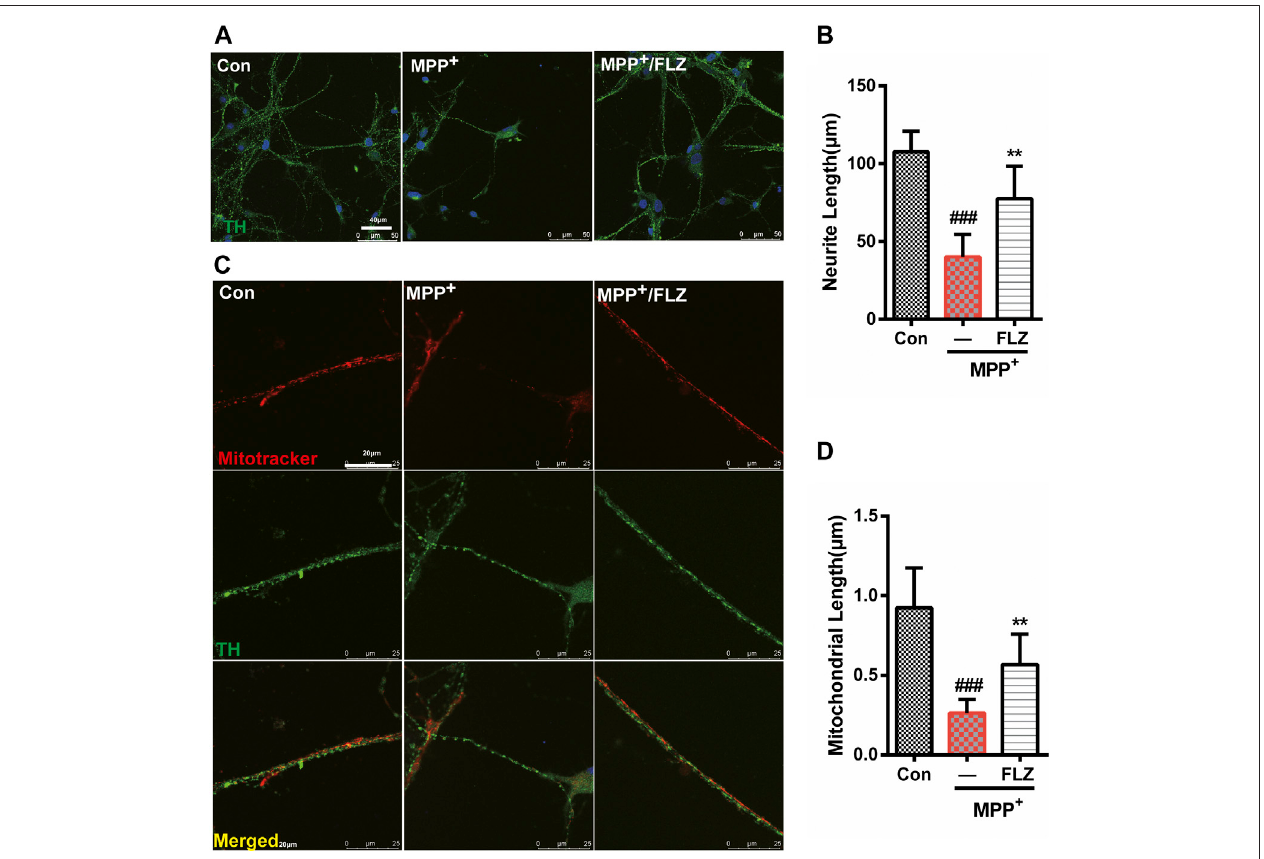
FIGURE 6 | FLZ treatment reduced neurite degeneration and mitochondrial fragmentation in primary dopaminergic neurons induced by MPP + Primary rat dopaminergic neurons were treated with FLZ (10 μ M) followed by incubated with or without MPP + (10 μ M) for 24 h (A) Cells were stained with TH antibody (green) and DAPI (blue).(Bar: 50 μ m) (B) Neurite length of primary dopaminergic neurons were measure byImage-pro Plus software (C) Cells werestained withTH antibody (green) andmitotracker(red)(Bar:20 μ m). (D) MitochondriallengthofprimarydopaminergicneuronswasmeasurebyImage-proPlussoftware.One-wayANOVAfollowed by Tukey post hoc comparisons tests were performed in all statistical analyses. ### p < 0.001 vs. Control group, * p < 0.05 and ** p < 0.01 vs. MPP + treated